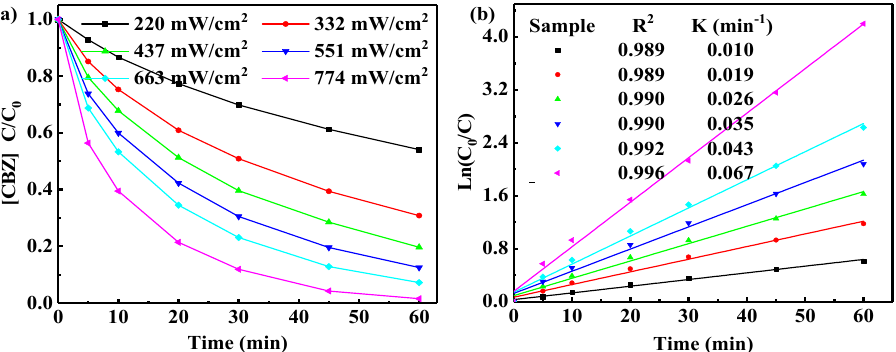
Figure 4. ( a ) Degradation of CBZ by UV-LED/TiO 2 with different light intensities. ( b ) The pseudo-first-order kinetic models of CBZ degradation by UV-LED/TiO 2 with different light intensities. C(CBZ) 0 = 18.8 µM; operating temperature = 20 °C; wavelength of UV-LED = 365 nm; operating pH = 7.6; and C (mixed-phase TiO 2 ) = 2.0 g/L.